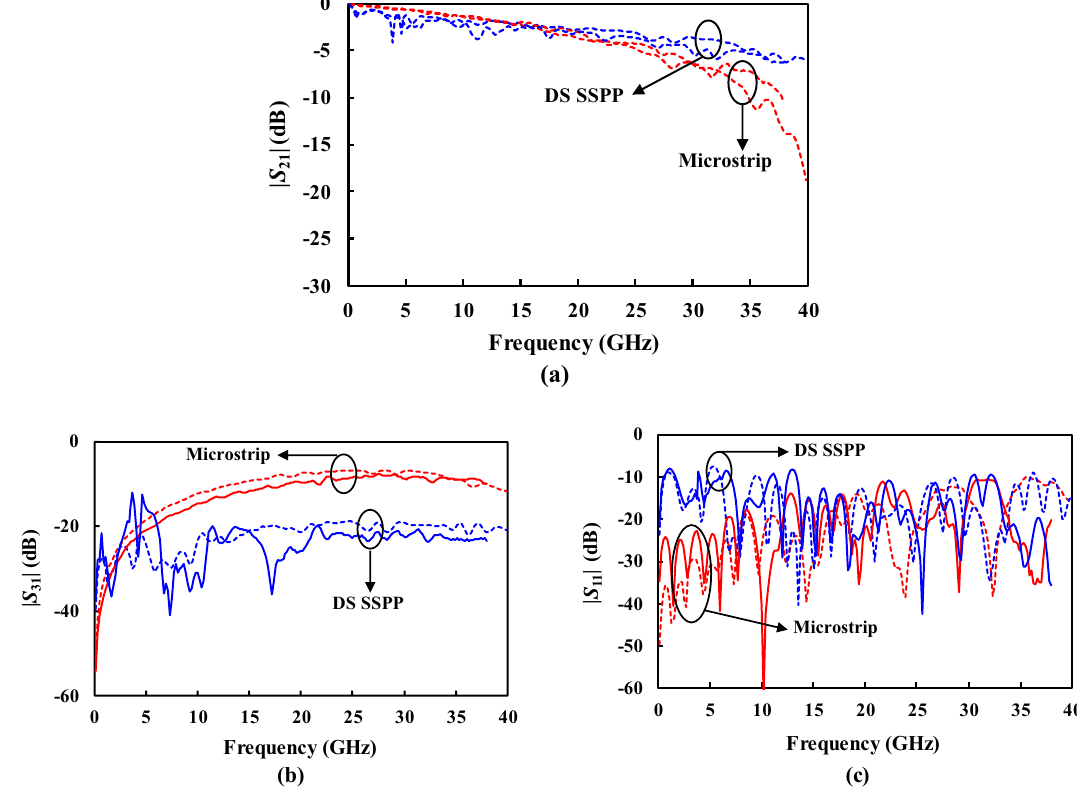
Figure 9. Measured (solid) and simulated (slotted) results of microstrip and DS SSPP coupled lines for G cl = 1.00 mm. ( a ) | S 21 | . ( b ) | S 31 | . ( c ) | S 11 | .